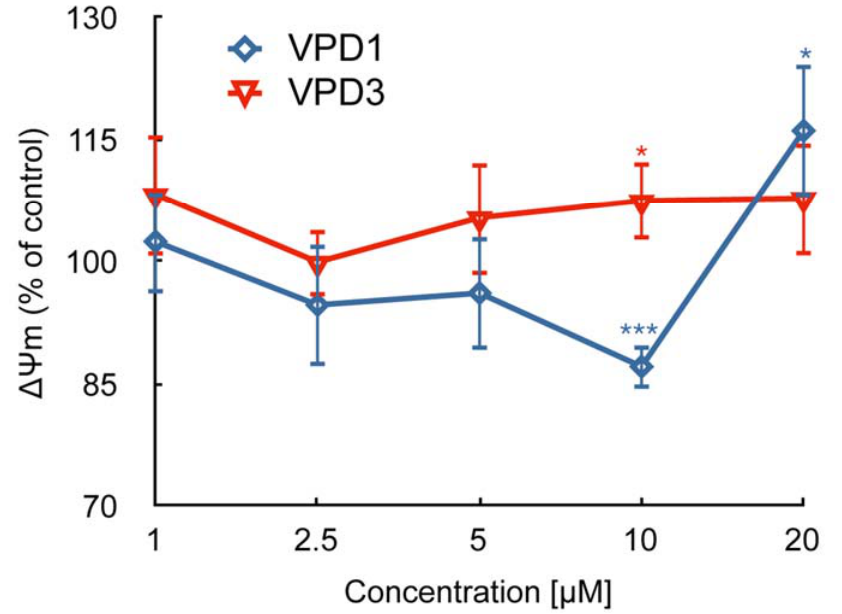
Figure 5. Mitochondrial membrane potential ( ΔΨ m) alterations in mHippoE-18 cell line after 24 exposure to VPDs measured using JC-1 probe (n = 5, * p < 0.05, ** p < 0.01, *** p < 0.001). CCCP was used as a positive control (46.21 ± 5.68 ***). There are statistical differences for VPD1 between concentrations 1 and 10 μ M, 1 and 20 μ M, as well as between VPD1 and VPD3 at the concentration of 10 μ